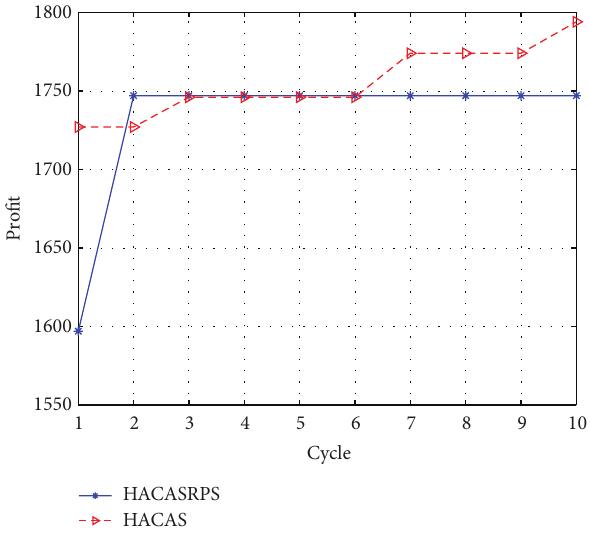
Figure 5: The profits of HACASRPS and HACAS algorithms. The horizontal axis represents the simulation cycle; the longitudinal axis represents the profit of the algorithm.